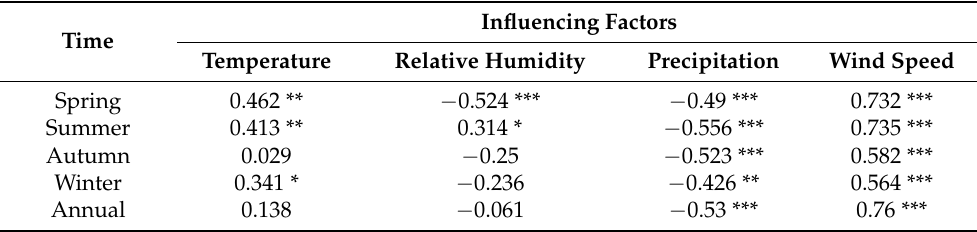
Table 3. Partial correlation coefficient between annual and seasonal SD and influencing factors (*, ** and *** refer to passing the p < 0.05, p < 0.01 and p < 0.001 significance tests, respectively). Influencing Factors Time Temperature Relative Humidity Precipitation Wind Speed Spring 0.462 ** − 0.524 *** − 0.49 *** 0.732 *** Summer 0.413 ** 0.314 * − 0.556 *** 0.735 *** Autumn 0.029 − 0.25 − 0.523 *** 0.582 *** Winter 0.341 * − 0.236 − 0.426 ** 0.564 *** Annual 0.138 − 0.061 − 0.53 *** 0.76